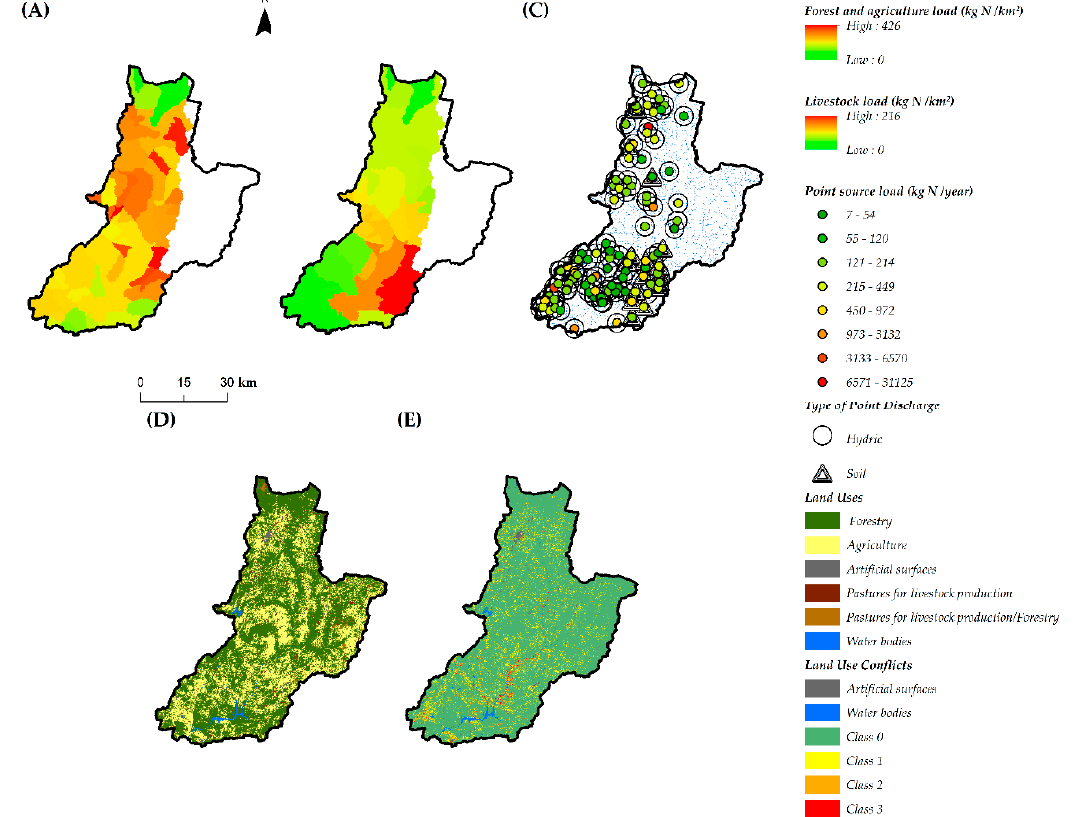
Figure 3. Spatial distribution of pressure variables used in the PLS-PM models: ( A ) forest and agriculture loads of nitrogen; ( B ) livestock loads of nitrogen; ( C ) point source discharges of nitrogen in soil and surface water; ( D ) land uses; ( E ) land use conflicts.